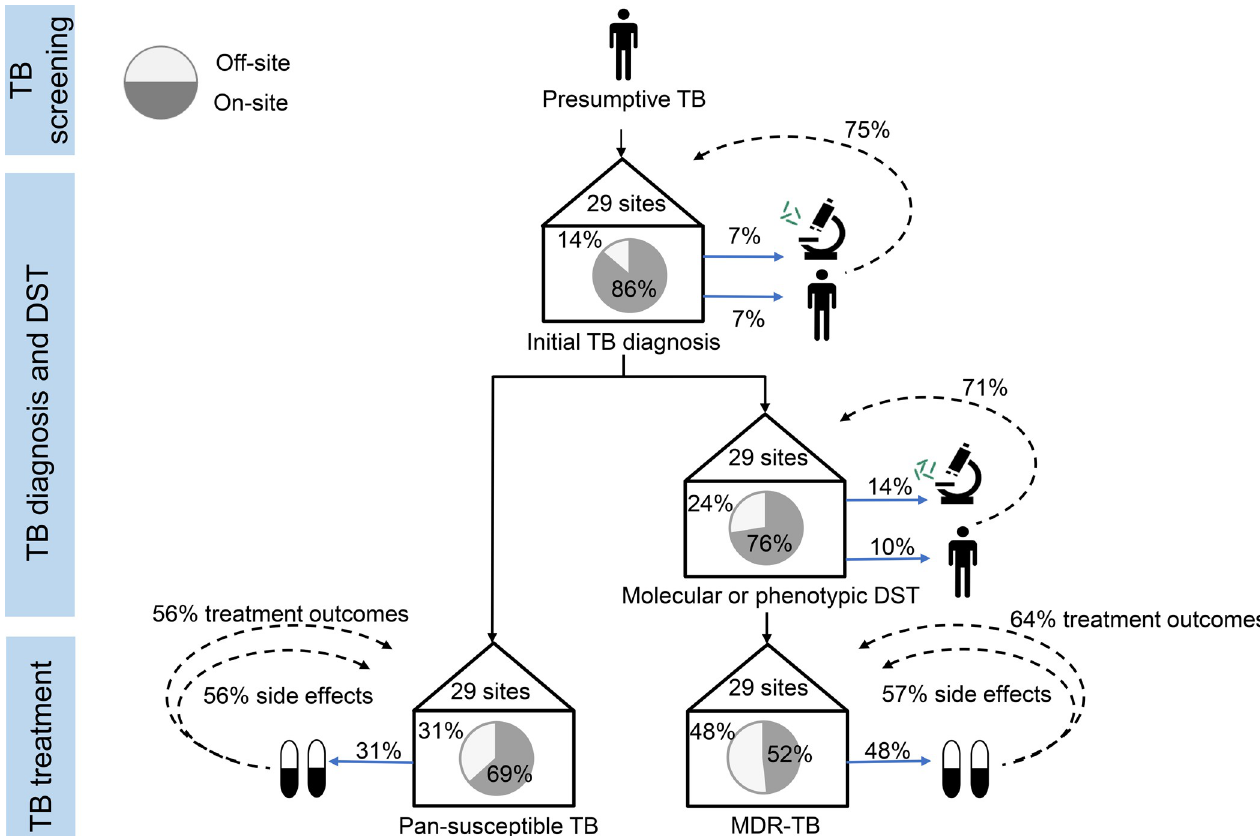
Fig 3. Care pathway for patients with HIV-TB coinfection at 29 ART clinics. Solid blue lines indicate patients or samples sent off-site for TB diagnosis, drug susceptibility testing (DST), or treatment. Dotted lines indicate feedback loops when diagnostic results, DST results, side effect or treatments outcomes are directly communicated back to the ART clinic by phone, written correspondence, or shared database entry. Abbreviations: DST, drug susceptibility testing; MDR, multidrug resistance; TB, Tuberculosis; XDR, extensive drug resistance.